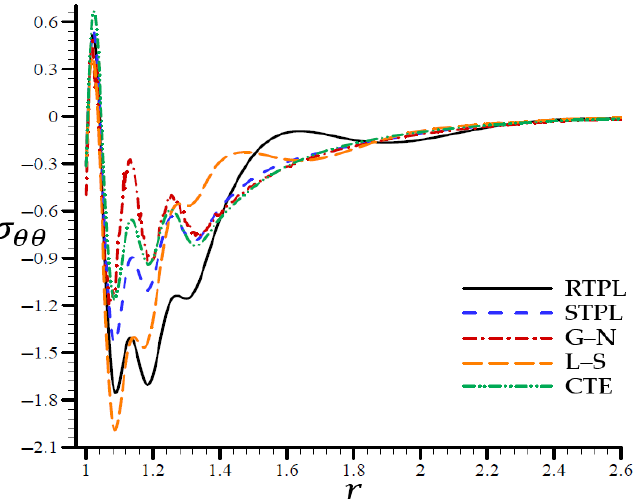
Figure 6. The circumferential stress 𝜎 𝜃𝜃 through the radial direction of a spherical hole for all models.